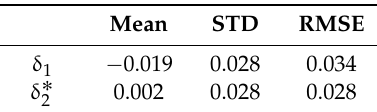
Table 2. Statistics of MODIS EVI minus VIIRS EVI ( δ 1 ) and MODIS EVI minus MODIS-compatible VIIRS EVI obtained in the optimization ( δ ˚